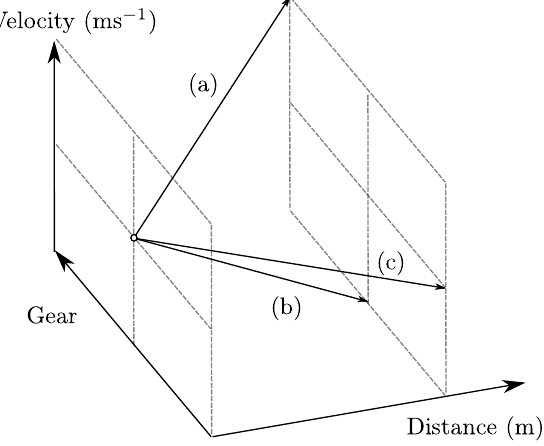
Figure 1. Dynamic programming search space with transitions ( a ) increasing velocity and selecting a higher gear; ( b ) decreasing velocity and ( c ) maintaining velocity and selecting a lower